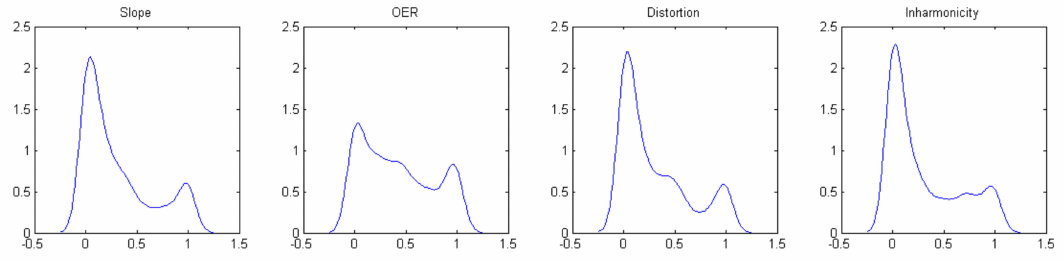
Figure 7. Probability density plot of slider distributions, X = Slider Value, Y = Probability density estimate. The bandwidth of the kernel smoothing window = 0.08. OER = odd / even ratio.